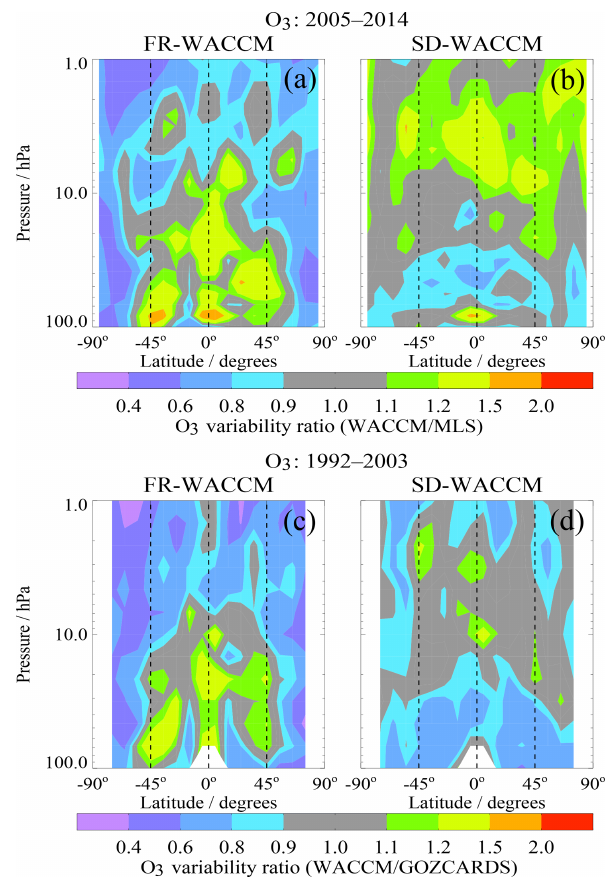
Figure 14. Variability ratios (model results divided by data results) for stratospheric O 3 , with FR-WACCM results on the left (a, c) and SD-WACCM on the right (b, d) . Before calculating the ratios, the variability values are obtained as the root mean square of detrended deseasonalized monthly anomaly time series and expressed as a per- centage of mean (climatological) abundances; (a, b) show compar- isons to MLS data for 2005–2014, whereas (c, d) are for 1992–2003 comparisons to